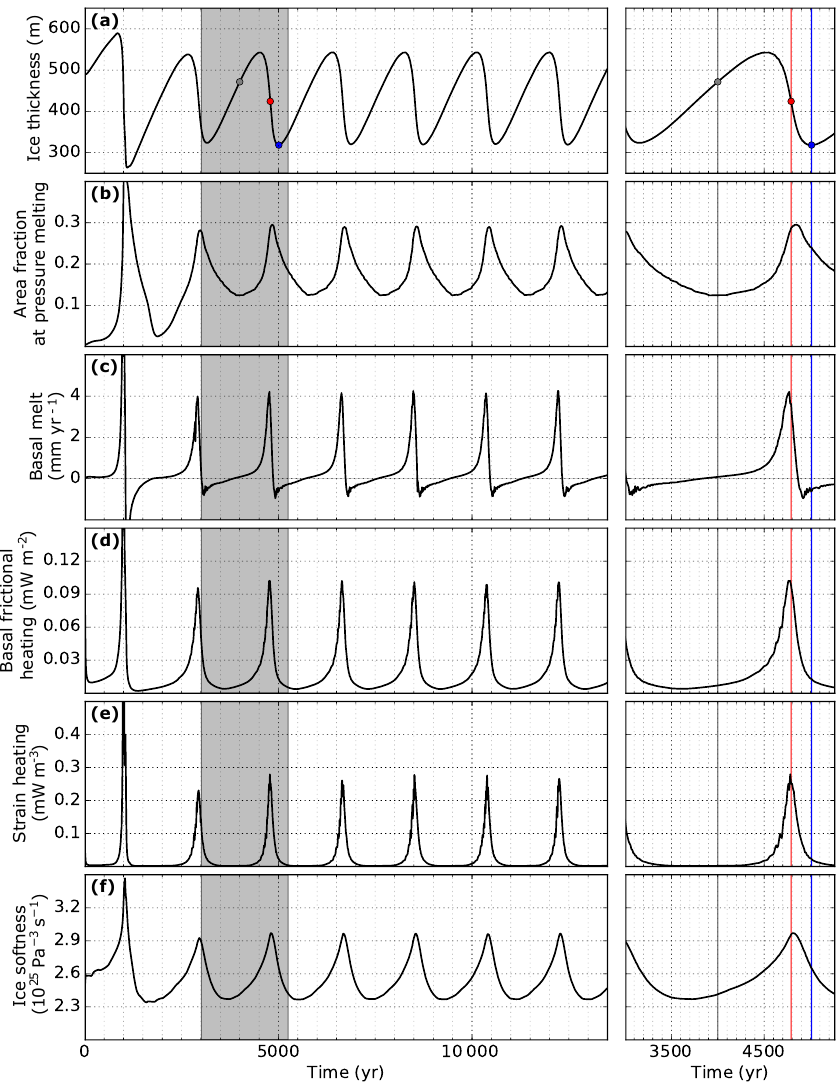
Figure A2. Additional time series to results in Fig. 3 of (a) ice thickness H , (b) fraction of grounded ice which is at pressure melting point at its base, (c) basal melt rate m , (d) basal frictional heating, (e) strain heating and (f) vertically averaged ice softness. Except for panel (b) , data shown are averaged over the area of grounded ice. The right-hand sides of the panels are analogue to the ones in Fig.